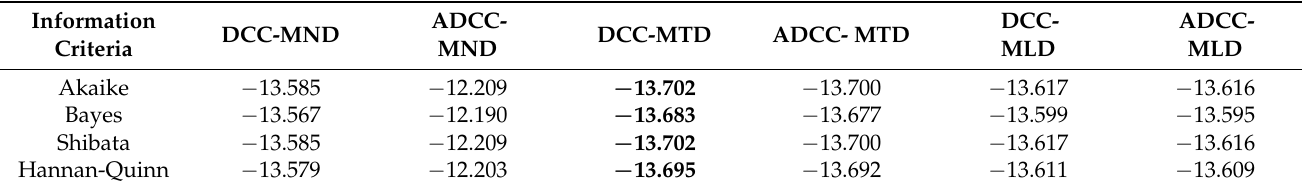
Table 4. Information criteria of (A)DCC-GARCH models for SHCI and USD